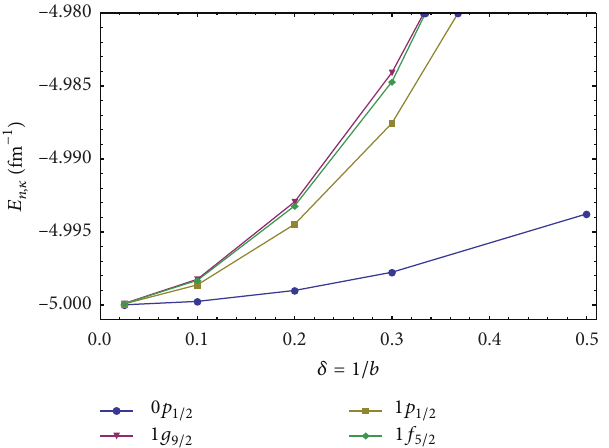
Figure 8: The variation of the energy spectrum 𝐸 𝑛,𝑘 for tensor Coulomb potential in the case of spin symmetry according to the screening parameter 𝛿 . Here we selected 𝑈 0𝐶 = 0.1 , 𝛼 = 0.01 .